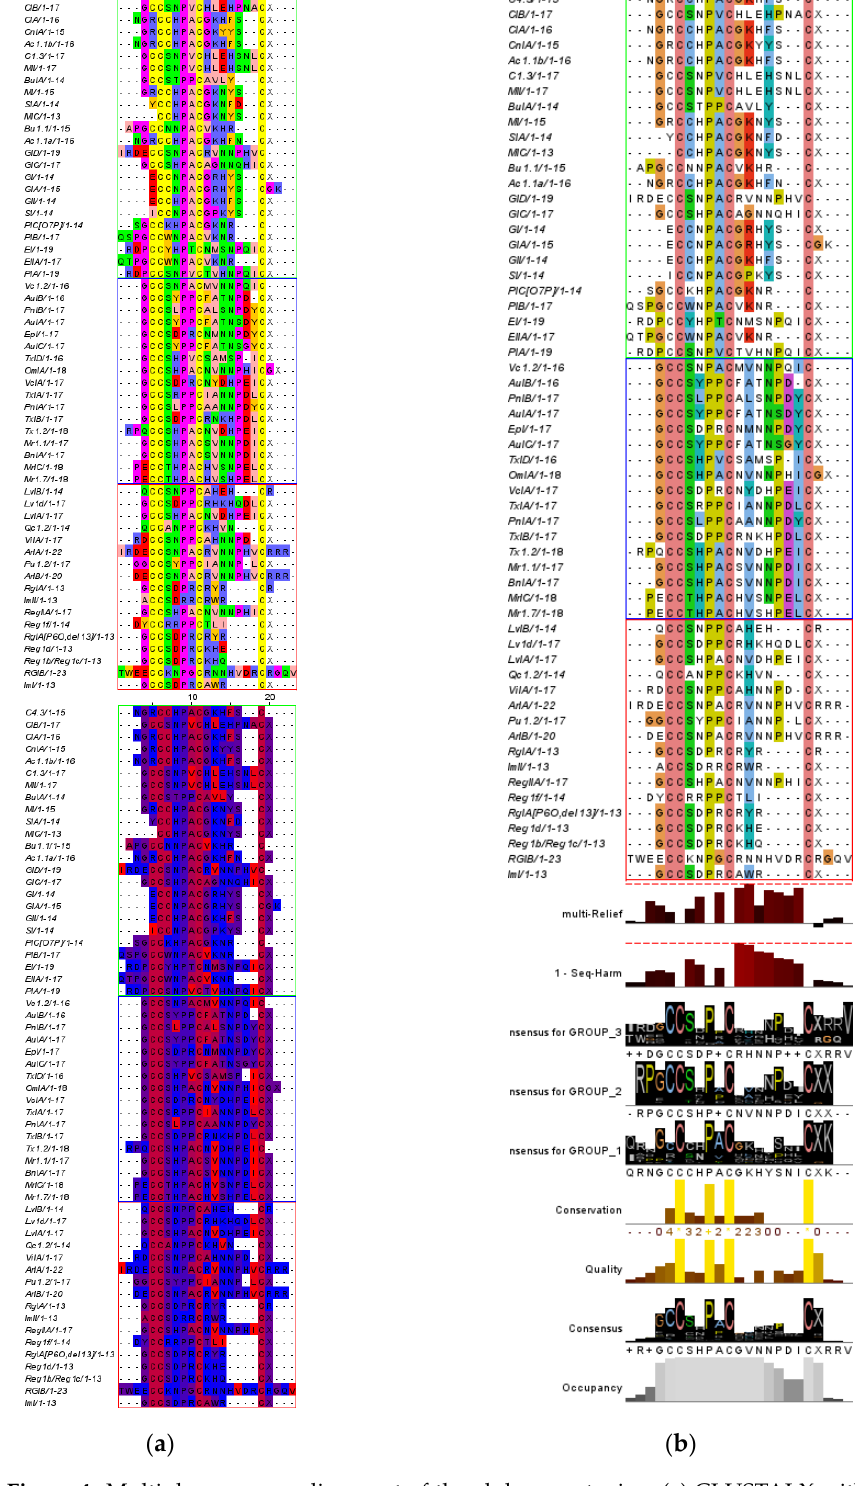
Figure 4. Multiple sequence alignment of the alpha-conotoxins: ( a ) CLUSTALX with histograms, ( b ) Zappo physicochemical color scheme, and ( c ) hydrophobicity color scheme. Group 1 (piscivorous) is enclosed in neon green, group 2 (molluscivorous) is enclosed in blue, and group 3 (vermivorous) is enclosed in a pink square.